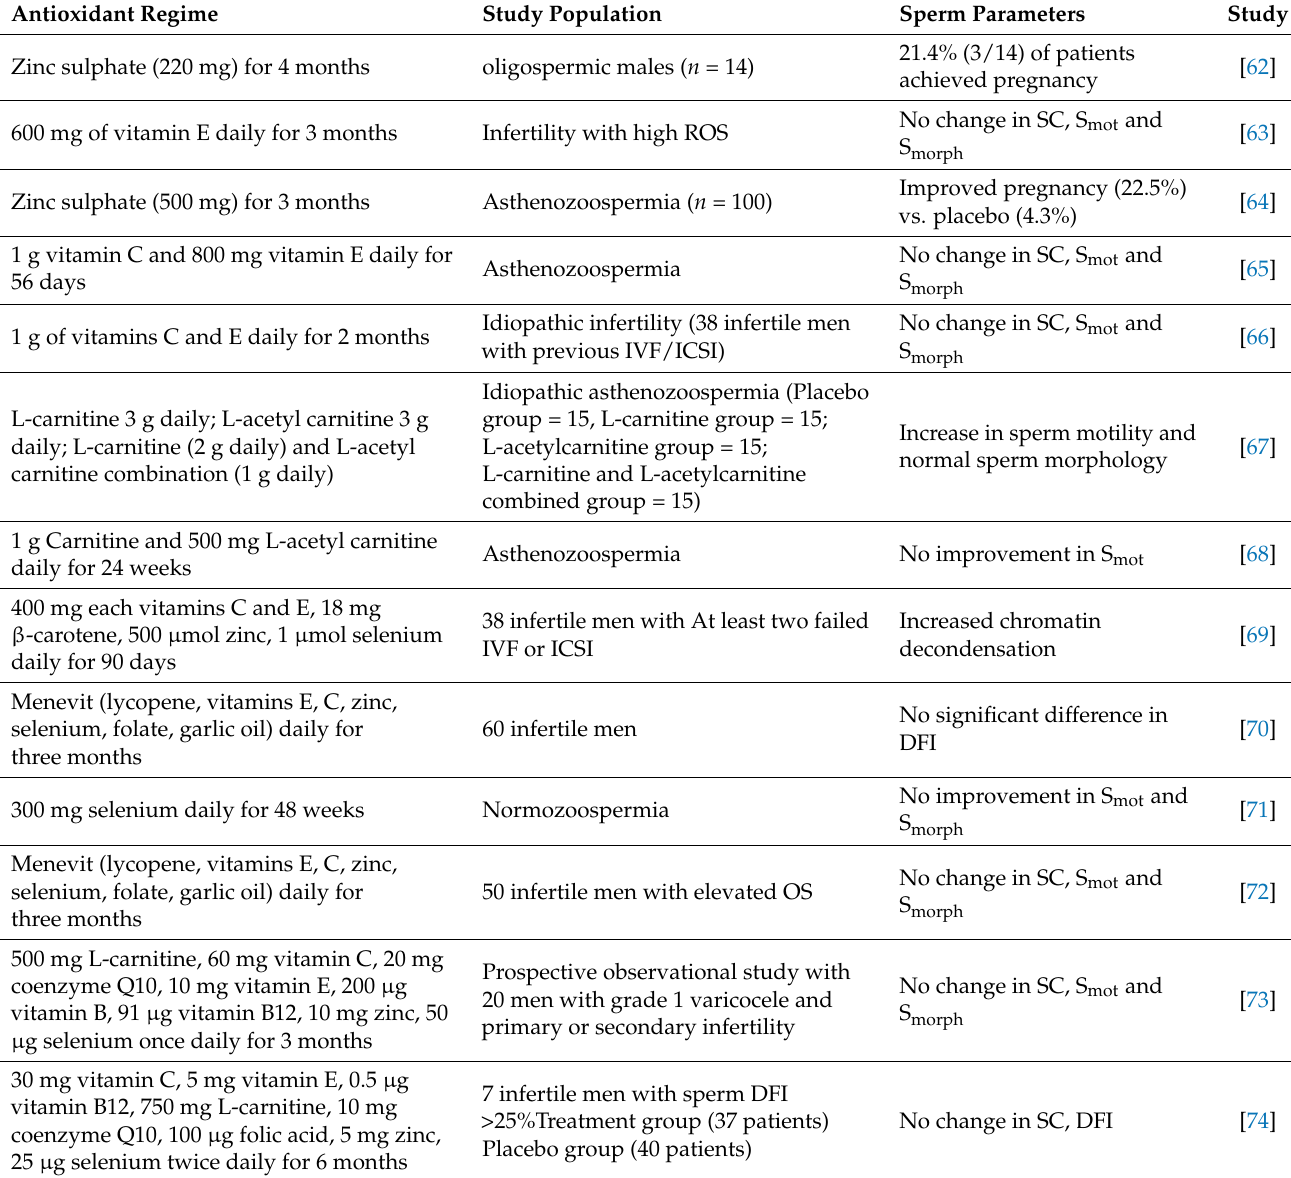
Table 1. Individual or combination antioxidant treatments with beneficial or no significant effects on semen